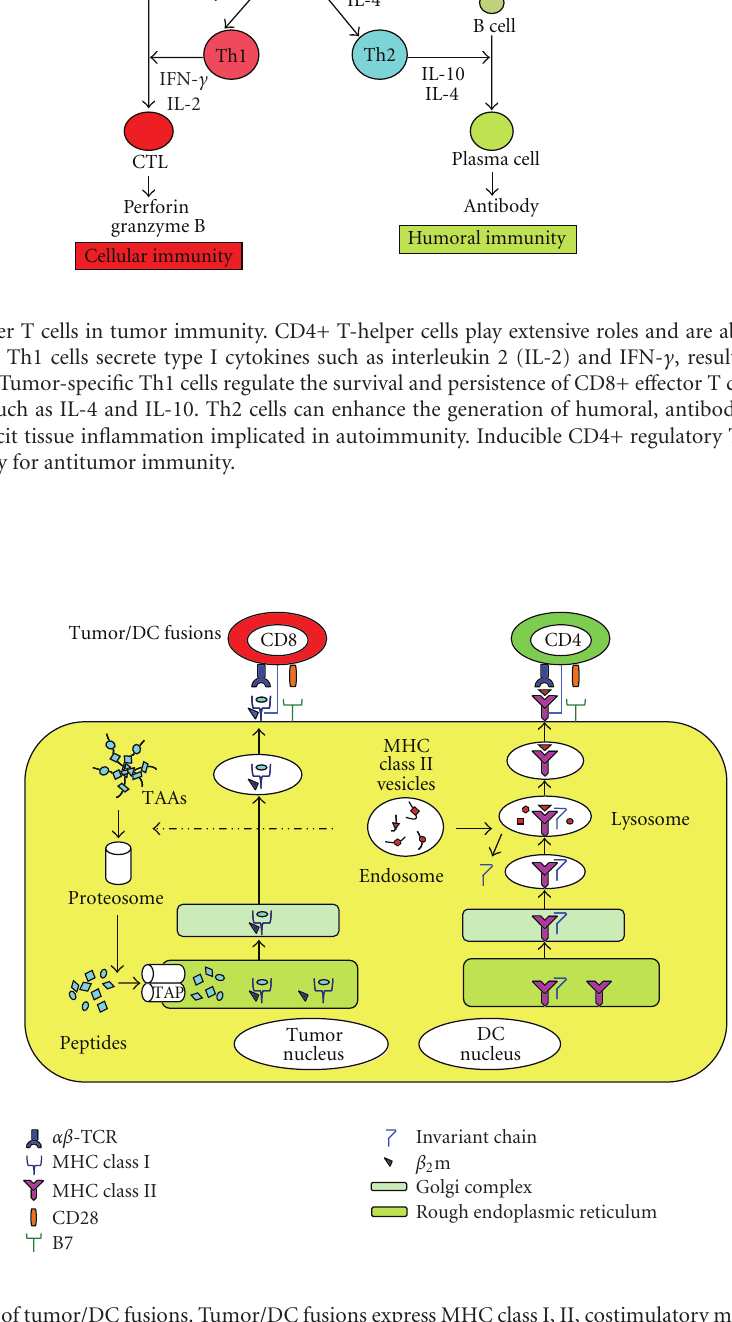
Figure 2: Characterization of tumor/DC fusions. Tumor/DC fusions express MHC class I, II, costimulatory molecules and tumor-associated antigens (TAAs). The fusions are able to process tumor-derived peptides and MHC class I peptides derived from DCs. They form MHC class I-peptide complexes, in the endoplasmic reticulum, which are transported to the cell surface and presented to CD8+ T cells. Similarly, the fusions can synthesize MHC class II peptides derived from DC in the endoplasmic reticulum, which are transported to the cytoplasm where MHC class II-peptide complexes are assembled with tumor-derived peptides and presented to CD4+ T